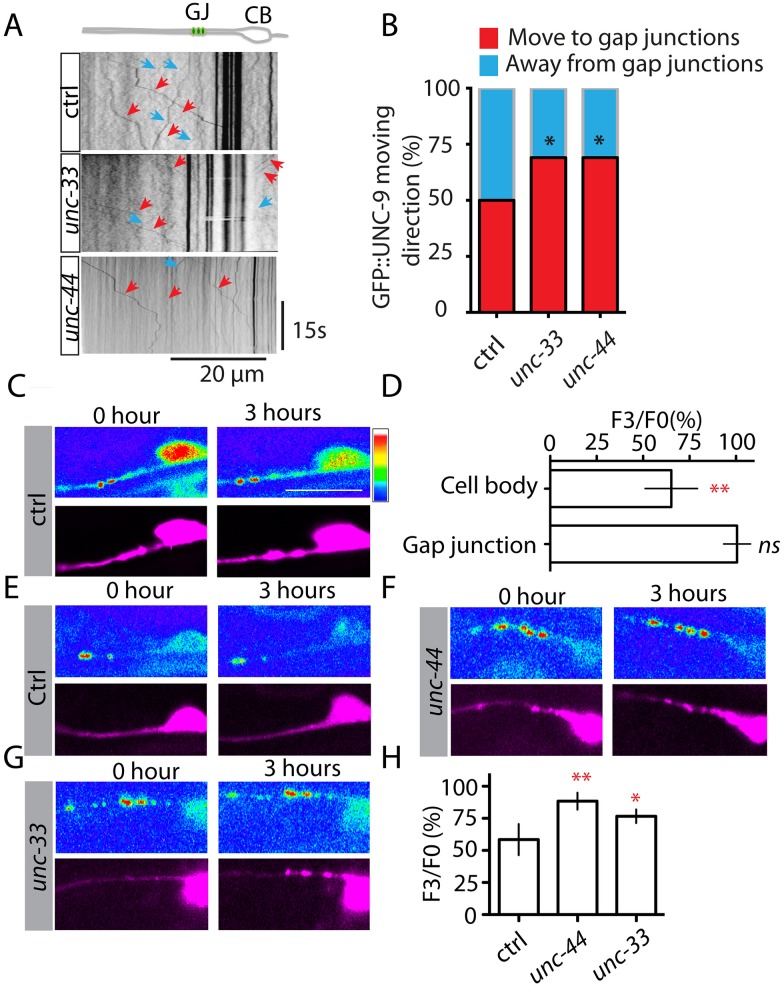
the UNC-44/UNC-33 pathway regulates gap junction dynamics and turnover.(A) Time kymographs generated from a 30s movie of GFP::UNC-9 dynamics in control, unc-33(lf) and unc-44(lf) animals. In the unc-44 kymograph, the strong GFP::UNC-9 puncta were out of focus to visualize the GFP::UNC-9 movement. (B) Quantification of the percentage of particles moving to (red color) and moving away from gap junctions (blue color) in control (n = 42 animals), unc-33(n = 38) and unc-44 (n = 38) based on the analysis of GFP::UNC-9 movement. Values that differ significantly from wild type (Fisher’s exact test) are denoted on the graphs (* p<0.05). Images (C) and quantification (D) show that photoactivation of PAGFP::UNC-9 at both cell bodies and axons induces 35% decrease of PAGFP::UNC-9 intensity at cell bodies after 3 hours, but does not change PAGFP::UNC-9 intensity at gap junction zone 1. The rainbow bar shows the color code for fluorescence intensity: from blue (low) to white (high). Images (E-G) and quantification (H) show that photoactivation of PAGFP::UNC-9 only at gap junction zone 1 induces 43% decrease of PAGFP::UNC-9 fluorescence intensity at gap junction zone 1 after 3 hours in control animals, and loss of function of unc-44 and unc-33 suppresses the decrease of PAGFP::UNC-9 intensity. In C, E, F and G the top panels show GFP signals from photoactivated PAGFP::UNC-9, and the bottom panels show mCherry signals from expression of Pmec-4::mCherry as internal controls. For quantification in D and H, F3/F0 was calculated based on: (PAGFP intensity/mCherry intensity 3 hours after photoactivation)/ (PAGFP intensity/mCherry intensity right after photoactivation)X100%, N>15 animals for each experiments. Data are shown as mean ± SD. Student’s t-test, ** p<0.01, * p<0.05, ns: no significant difference. Scale bar: 10 μm.